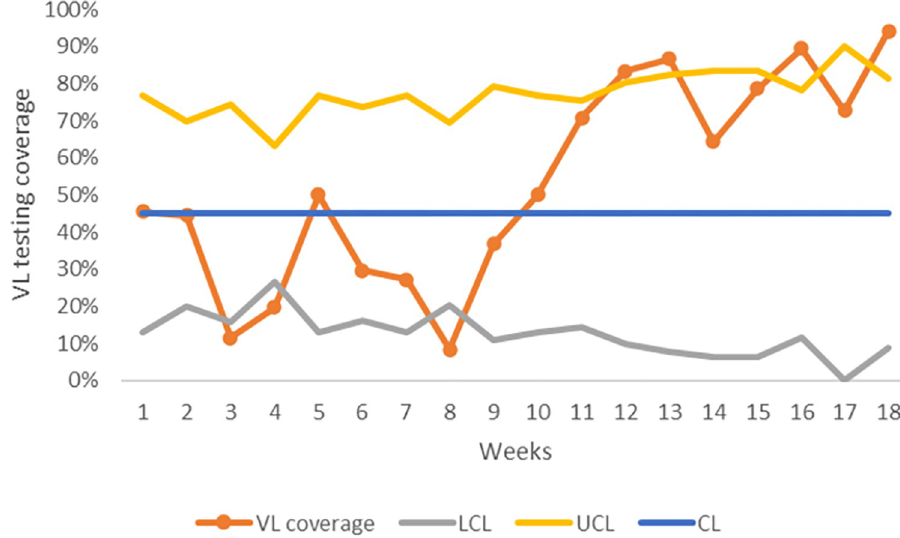
Fig 5. P-Chart of VL testing coverage at Chilomoni health center with upper and lower control limit.